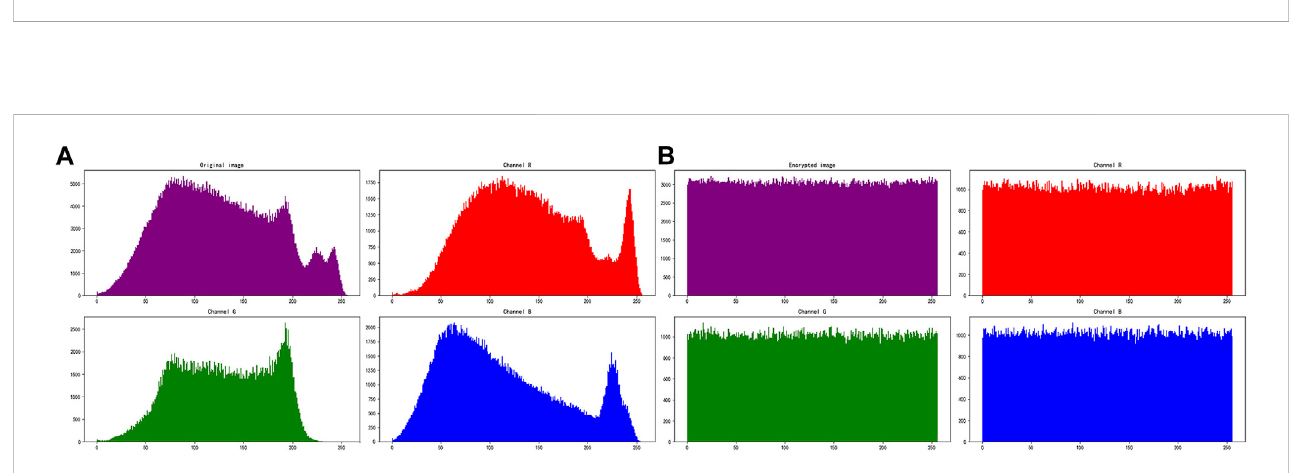
FIGURE 5 Histogram distribution of Baboon: (A) is original image ’ s histogram, and (B) is encrypted image ’ s histogram.